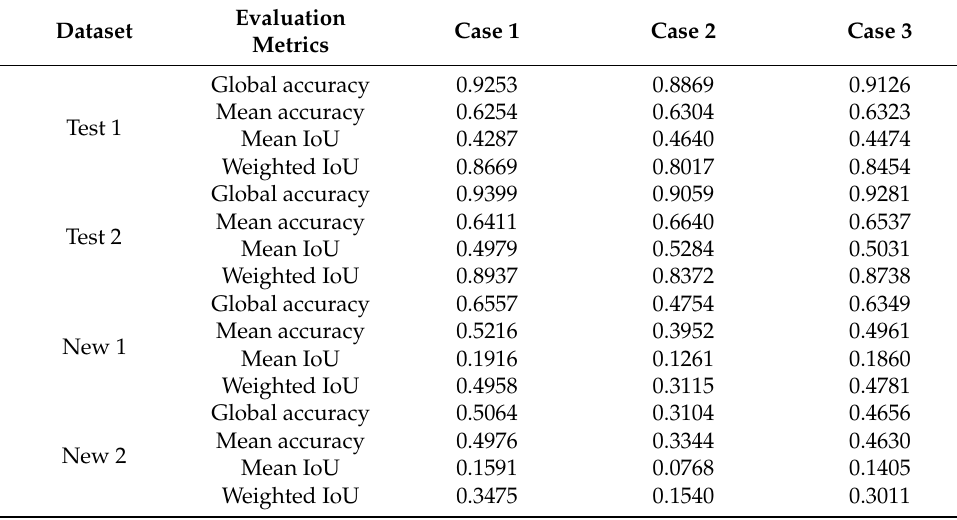
Table 3. Evaluation metrics of test and new data for each case.